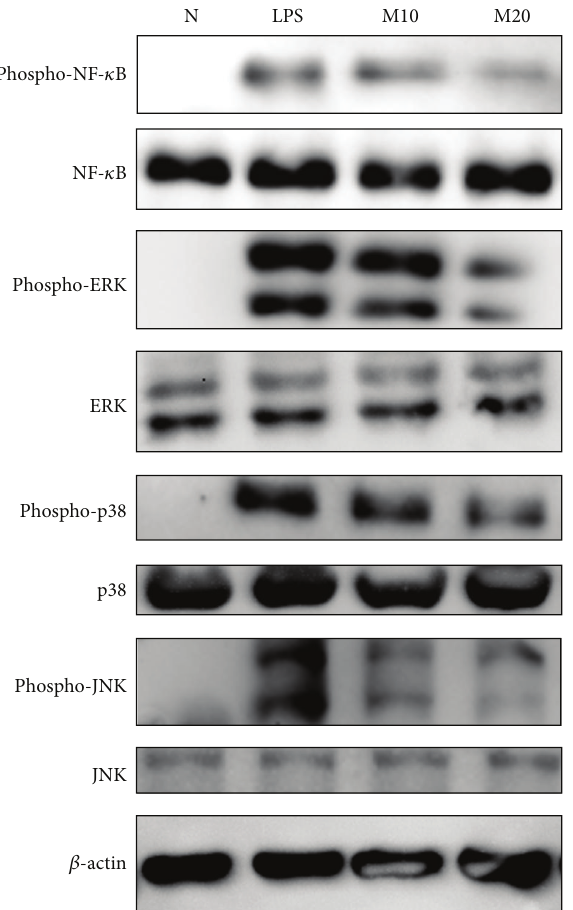
Figure 8: Matrine affects the LPS-induced nuclear phosphorylation of NF- 𝜅 B and phosphorylation of MAPK pathway molecules. Phosphorylation in lung tissue was analyzed by Western blots. Three independent experiments were analyzed and results were compared with the LPS-treated group.